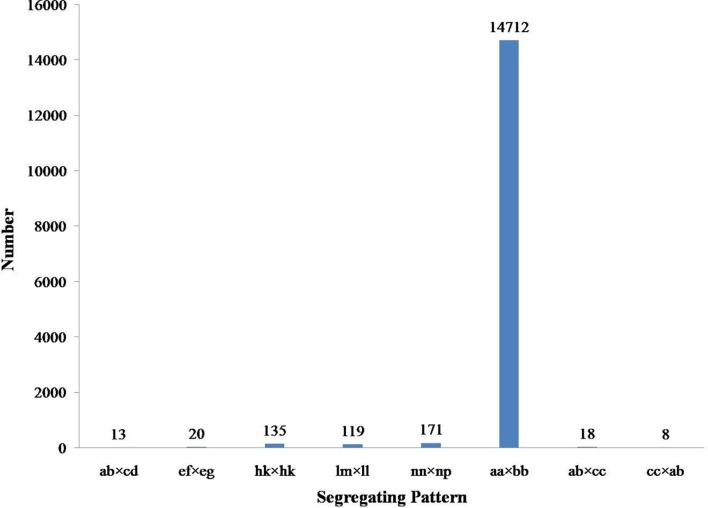
Gnotype distribution of SLAF markers. The Y axis is the number of SLAFs, the X axis is the type of SLAFs.